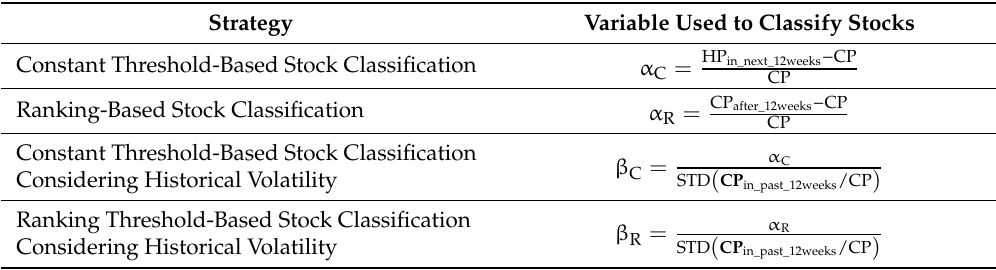
Table 2. Summary of the proposed four strategies for stock